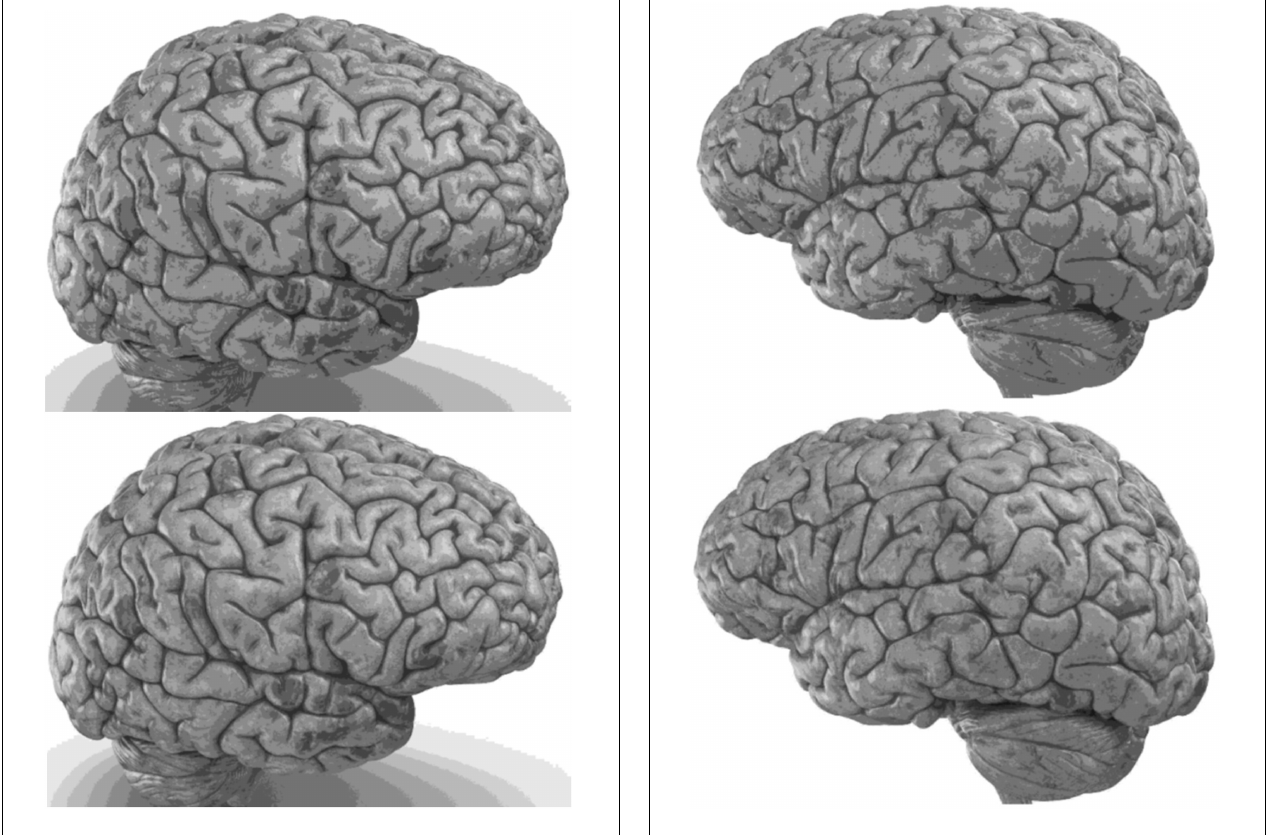
FIGURE 8 | 3D image from the right viewing angle. FIGURE 9 | 3D image from the left viewing